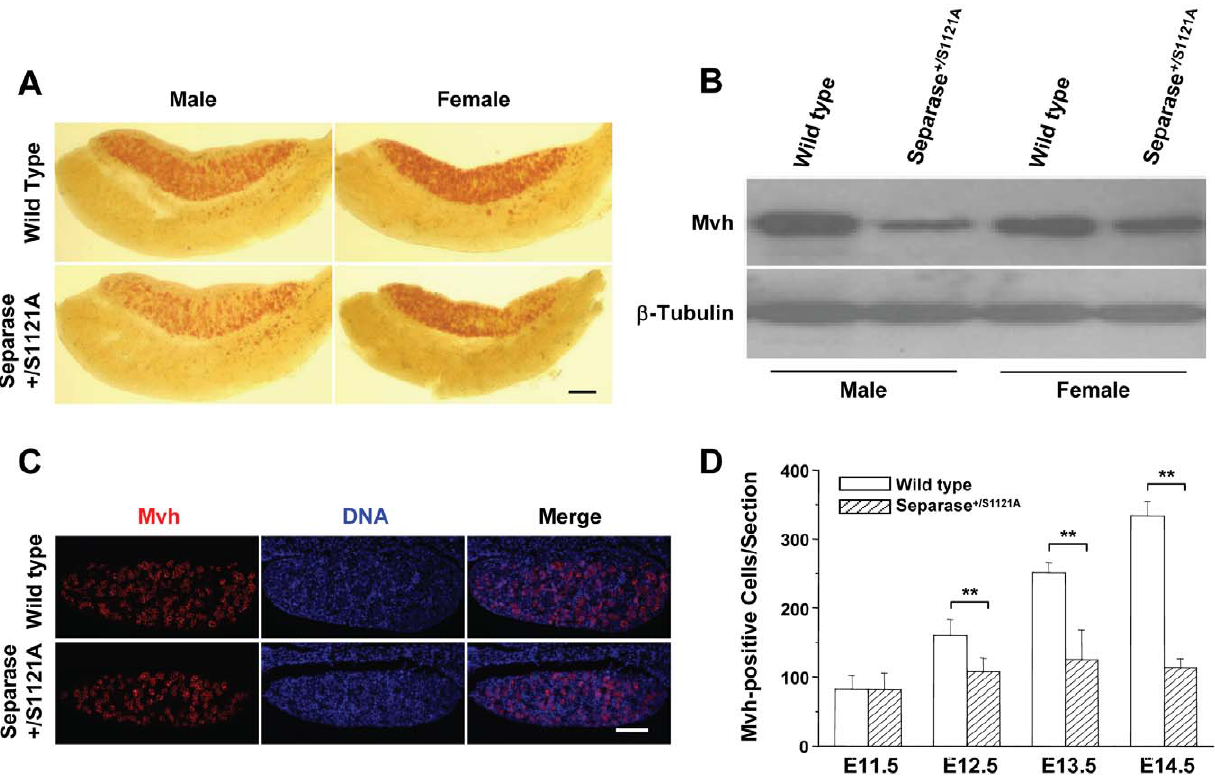
Figure 2. Partial depletion of PGCs in female Meox-2-cre/Separase S1121A mutant mice. A. Whole-mount TNAP staining of female gonads of 13.0 dpc. TNAP-positive cells are red. Bar=20.0 m m. B. Western blot detection of Mvh of gonads at 13.0 dpc. C. Mvh immuno-staining of gonads at 13.0 dpc. Mvh-positive cells are red. Bar=4.0 m m. D. Quantitative analysis of Mvh-positive cells in female gonads of different stages. Serial sections of female genital ridge were stained for DNA and Mvh. The Mvh-positive cells were scored from at least three sections in at least three embryos (at least six genital ridges) for each time point. The mean value is shown with standard error (** p , 0.001, T test).